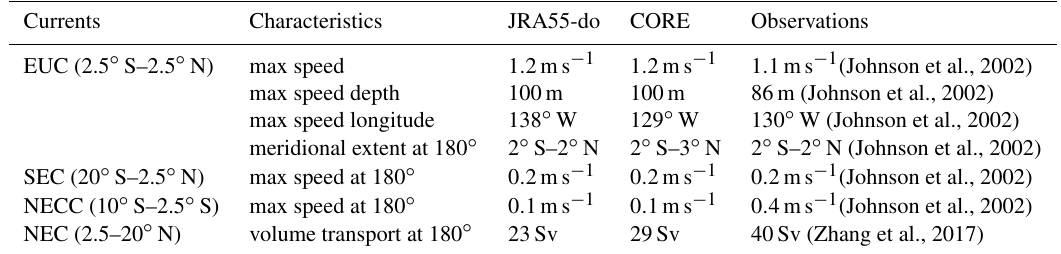
Figure 7. The 1993–2007 time-mean net surface heat flux in JRA55-do (a) , CORE (b) , and CORE minus JRA55-do (c) . Positive value indicates an energy flux into the ocean. Note the different scales of the two color bars. Table 1. Comparison between observation and JRA55-do/CORE simulations for various tropical Pacific